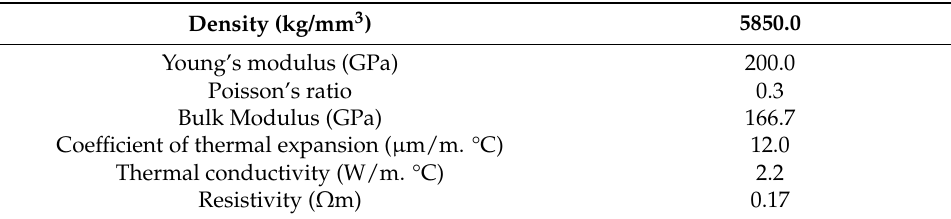
Table 4. Properties of Yttria Stabilized Zirconia